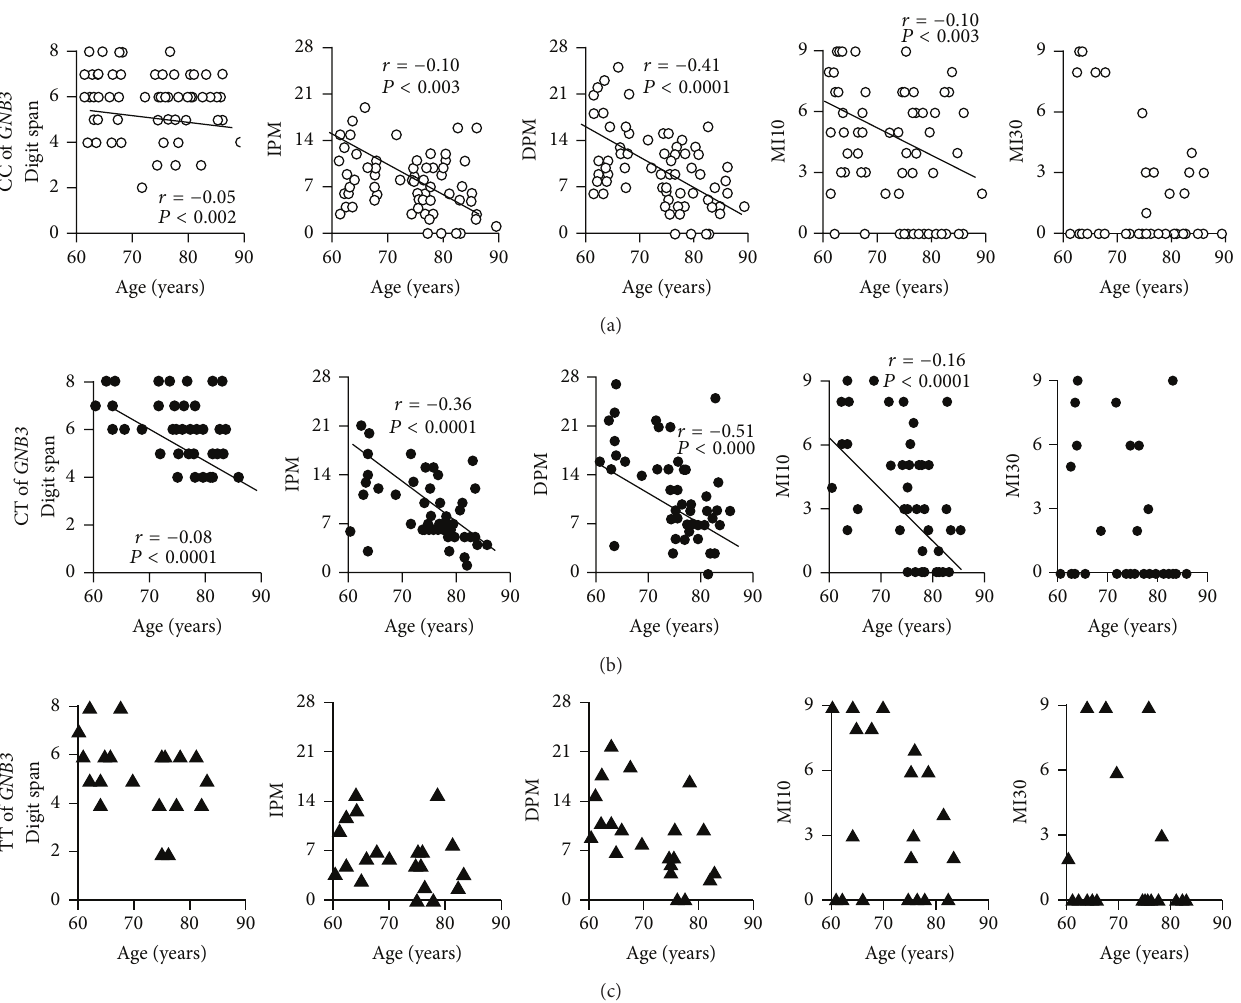
Figure 4: Regression of age with the neupsychological tests in 220 subjects from general